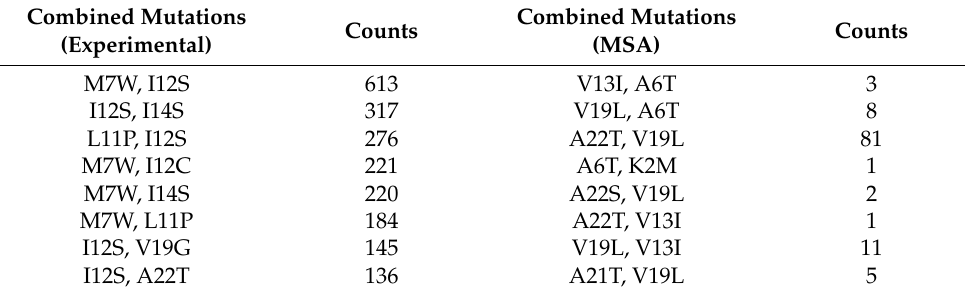
Table 1. Compensatory mutations in the TM region of